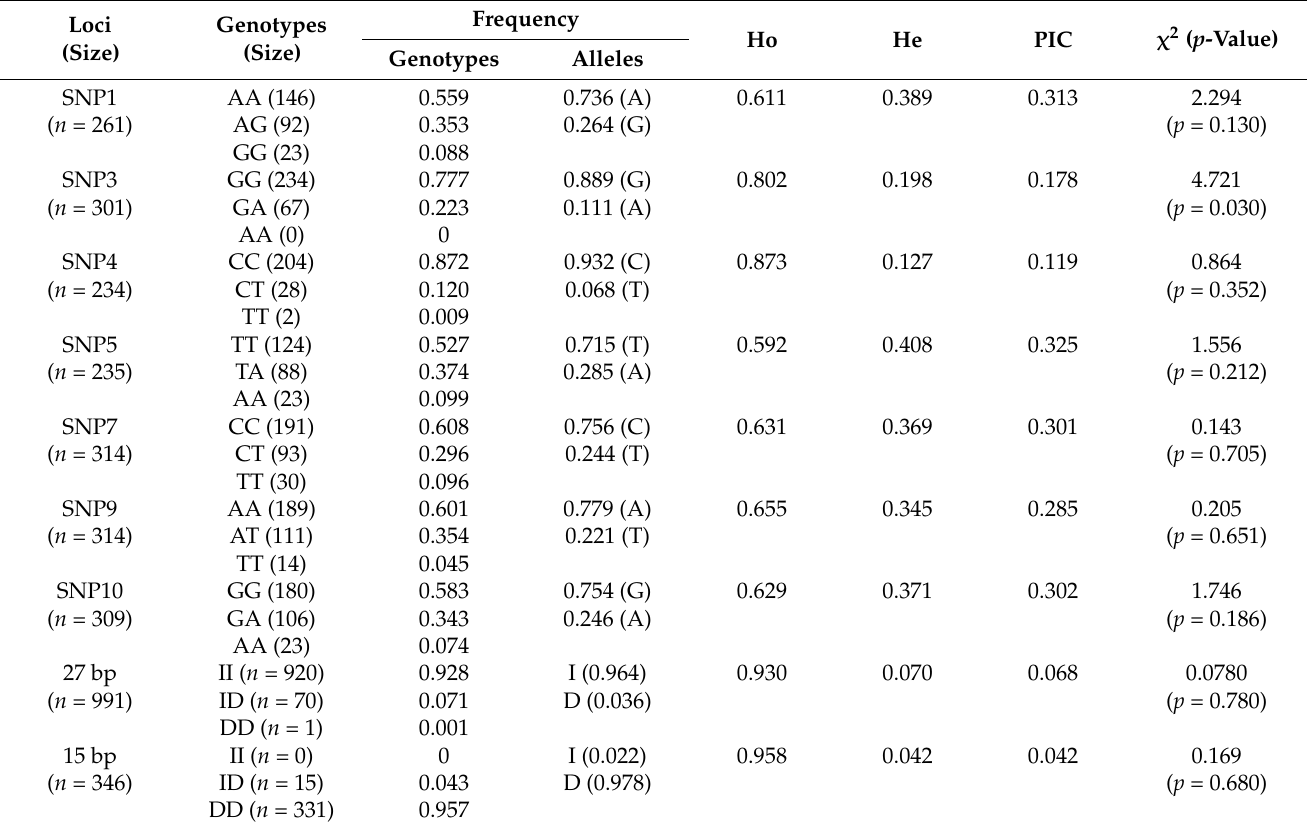
Table 2. Genotypic Frequencies and Population Indexes for SNP and InDel Mutations of DNAH1